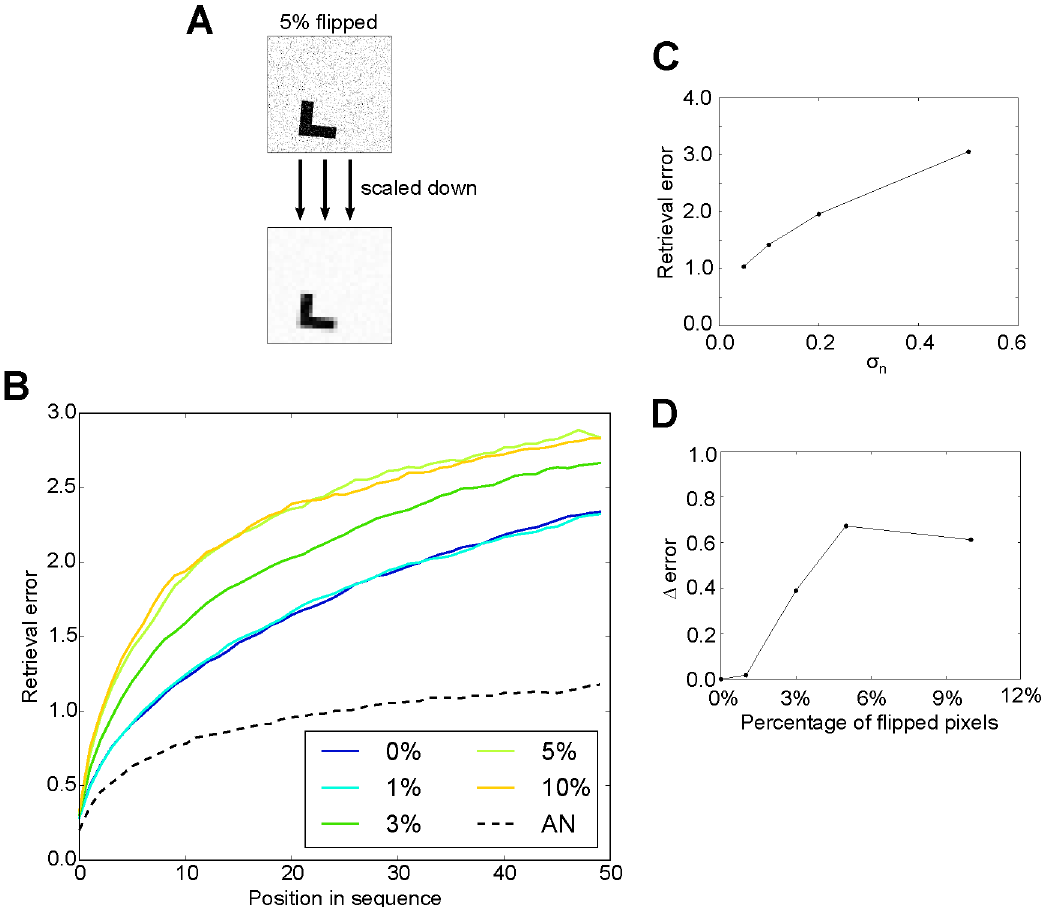
Fig 8. Retrieval performance with “pattern separation” in the sensory system. A: Example of the manipulated input patterns. Top: same pattern as in Fig 1B, but with 5% pixels flipped (300 × 300 pixels); Bottom: the scaled version. B: Retrieval error as a function of the fraction of randomly flipped pixels in the input image ( σ = 0.2, 200 stored sequences). Dashed curve: retrieval n performance of the model with neurogenesis ( σ a = 1) for comparison. C: With the same amount of noise in the input (1% flipped pixels), retrieval error increases monotonically with increasing retrieval noise σ . D: The difference between the retrieval error for n original patterns and that for noisy input pattern gradually increases with input noise ( σ n = 0.2). Values in C and D are drawn from the 30 th element in the